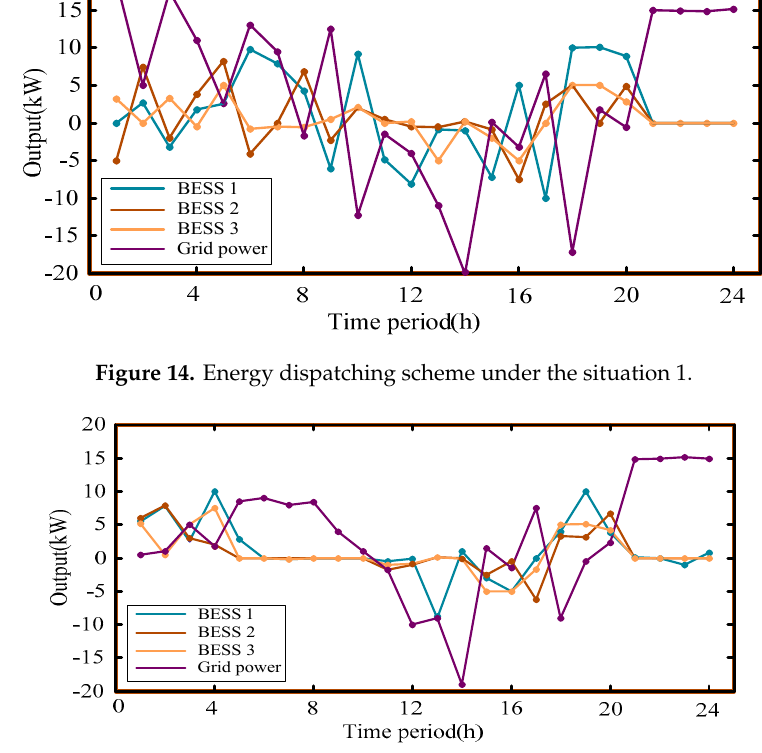
Figure 15. Energy dispatching scheme under the situation 2.